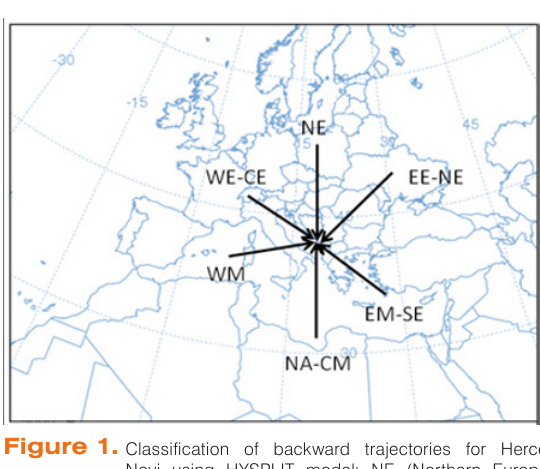
Figure 1. Classification of backward trajectories for Herceg Novi using HYSPLIT model: NE (Northern Europe), EE-NE (Eastern Europe-Northeastern Europe), EM-SE (Eastern Mediterranean-Southeastern Europe), NA-CM (Northern Africa-Central Mediterranean), WM (Western Mediterranean), and WE-CE (Western Europe-Central